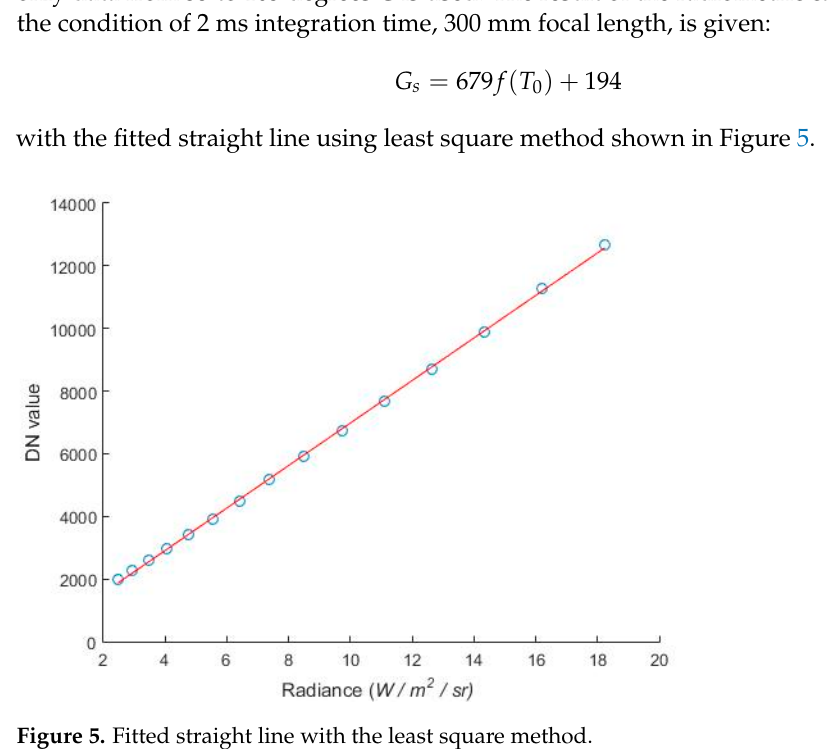
( e ) Figure 6. Blackbody source in field test with different temperatures in degree C: ( a ) 65; ( b ) 75; ( c ) 85; ( d ) 95; ( e ) 105. The radiance calculated according to Planck’ law of radiation and corresponding DN value are listed in Table 4. Table 4. Radiance and DN value for the blackbody test. Temperature/°C Radiance/W·m − 2 ·str − 1